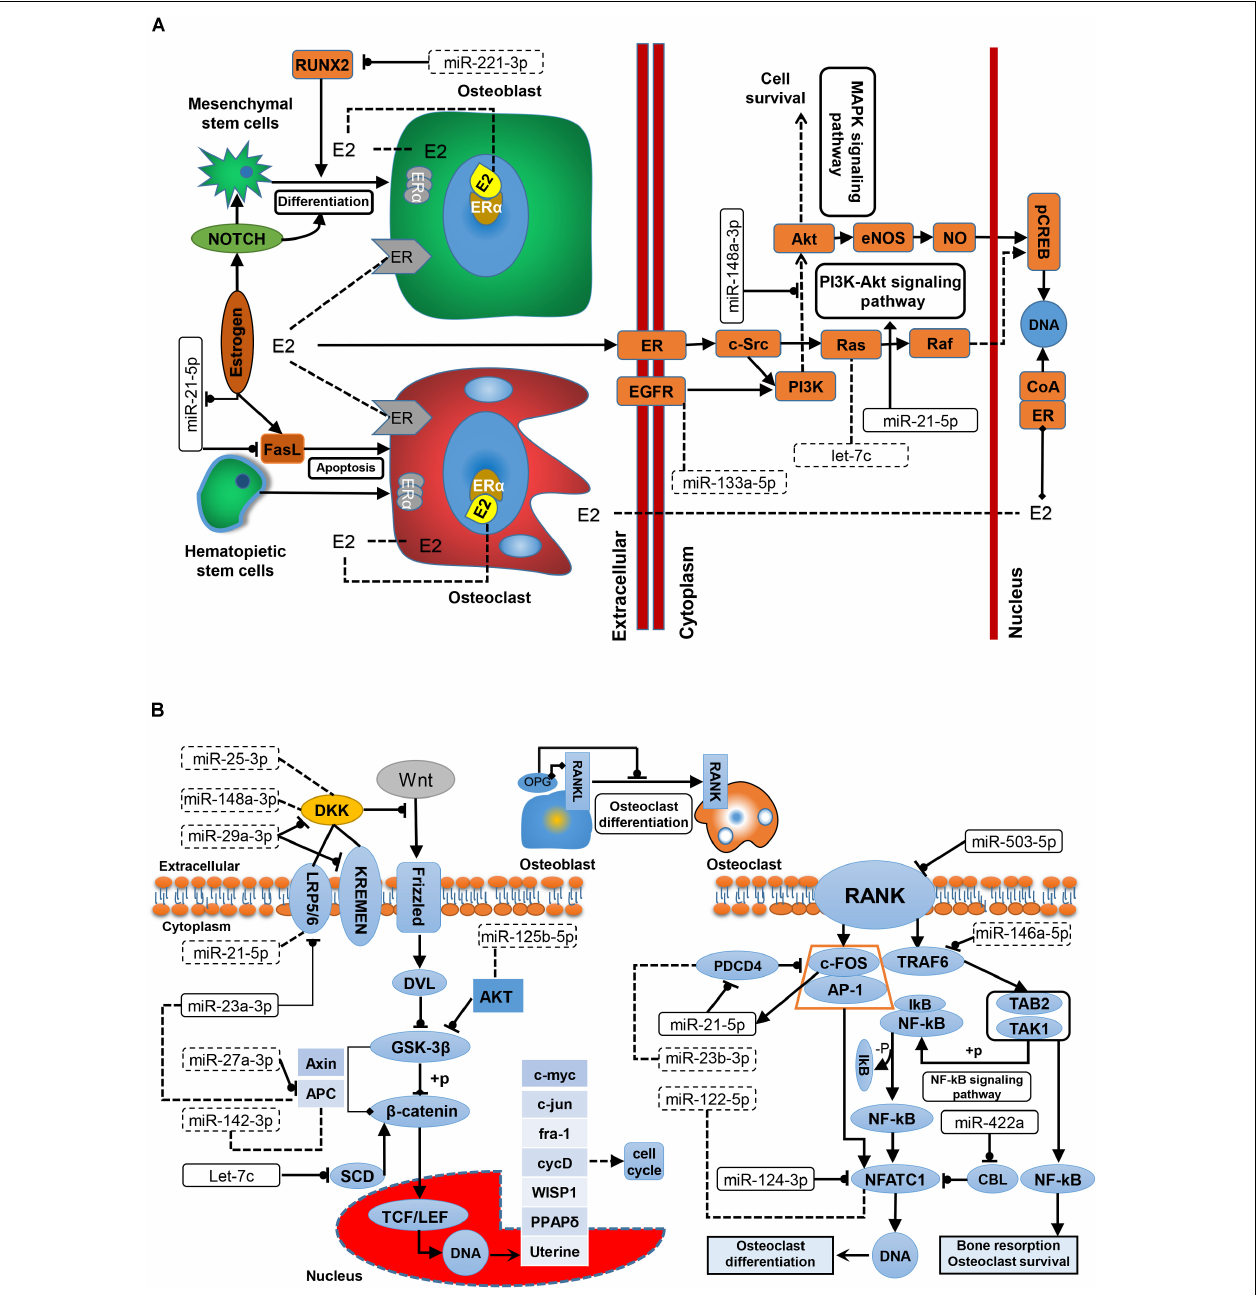
FIGURE 3 | The regulatory role of miRNAs in OP-associated pathways. (A) In the estrogen signaling pathway. Estrogen-mediated systemic signaling has protective effects on BMD in OP. (B) In the WNT/ β -catenin and RANKL/RANK/OPG pathway. The WNT/ β -catenin signaling pathway is the major signal transduction pathway regulating osteoblast differentiation. The RANKL/RANK/OPG pathway may regulate the development of osteoblasts and osteoclasts. E2, 17 β -estradiol; EGFR, epidermal growth factor receptor; ER, estrogen receptor; LRP, low-density-lipoprotein receptor-related protein; OPG, osteoprotegerin; RANKL, receptor activator for nuclear factor- κ B ligand; RANK, receptor activator for nuclear factor- κ B; RUNX2, Runt-related transcription factor